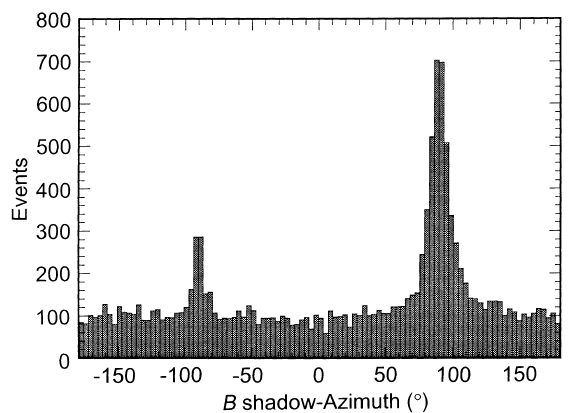
Fig. 7. Histogram of the difference between B shadow and trace azimuth. Notice the sharp peaks at azimuths (cid:6) 90 (cid:14) from B shadow, representing the MED and retrograde events, respectively